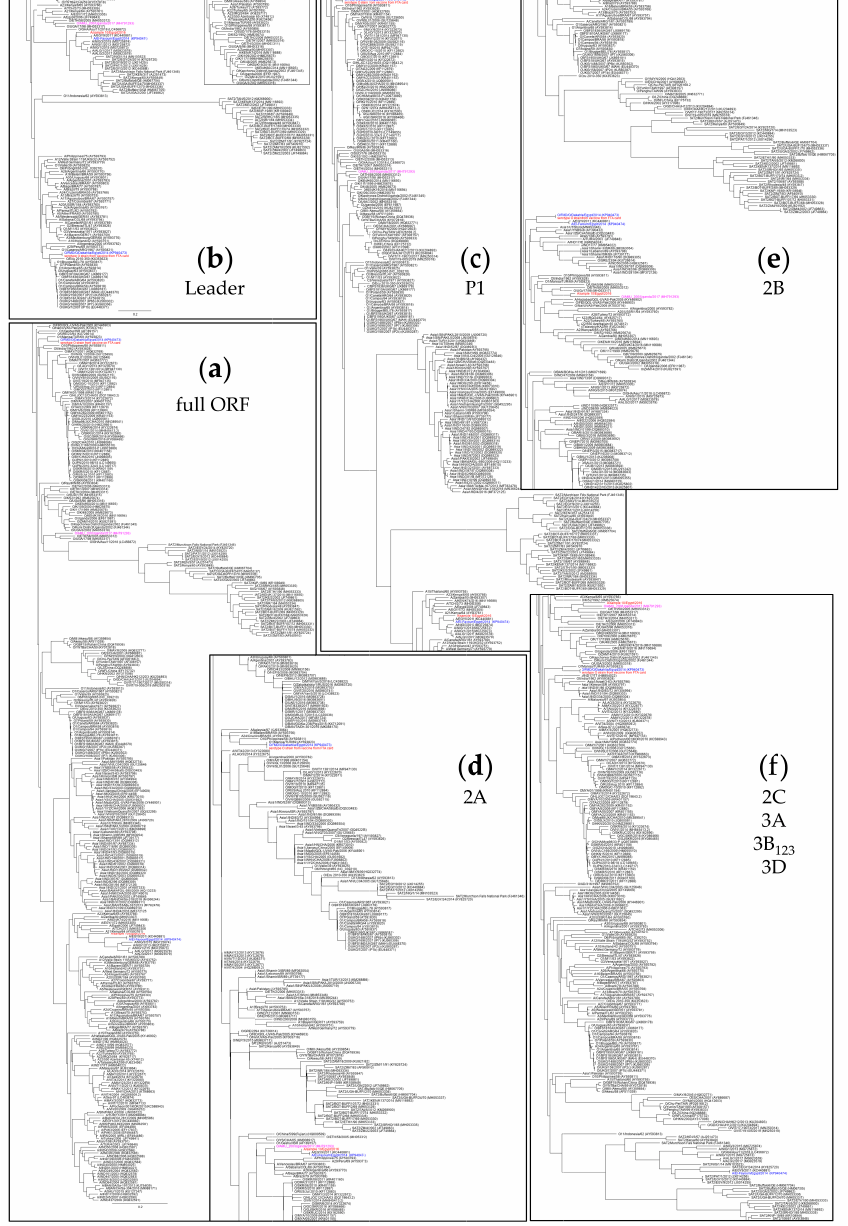
Figure 2. Phylogenetic trees for ( a ) the full open reading frame (ORF), ( b ) the leader